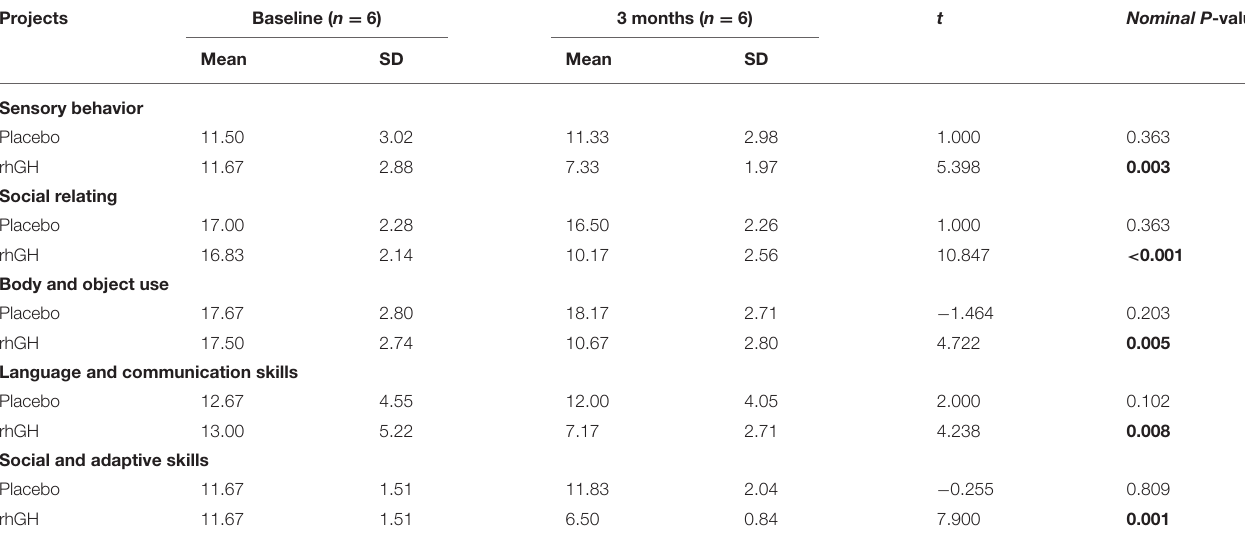
TABLE 7 | Comparison of subscale scores of SC-ABC before and after treatment. Projects